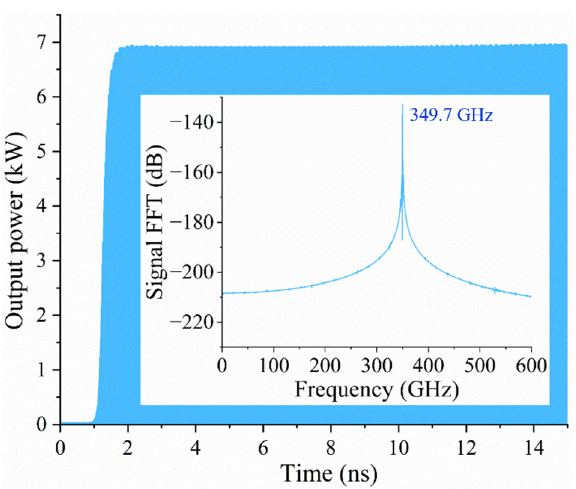
Figure 11. Time-dependent output power and frequency spectrum with the current of 5I 0 for beam Ⅰ and the current of I 0 for other beams.